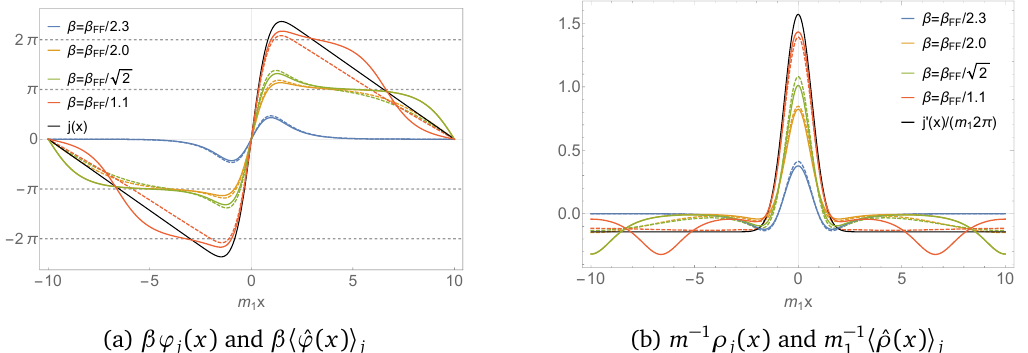
Figure 4.1: Comparing quantum and classical profiles for different values of the coupling β . (a) The QFT expectation values 〈 β ˆ ϕ ( x ) 〉 (dashed lines) and the classical lowest en- j ( x ) (continuous lines). ergy configurations βϕ j 〈 ˆ ρ ( x ) 〉 (b) The corresponding topological charge densities m − 1 in the quantum case j 1 ( x ) in the classical case (continuous lines). (dashed lines) and m − 1 ρ j = 18, m σ = 2 / 3; dif- L = 20, m = m A / m The parameters are (cid:96) = m , β (cid:112) 1 1 FF 1 1 = ferent β values are shown with different colours and β 4 π . The classical FF solutions for the two intermediate β values have βϕ ( 0 ) = π and are shifted by − π . The TCSA profiles 〈 ˆ ρ ( x ) 〉 = 24,26,28 and were extrapolated using cut-offs e j c 30, and the corresponding profiles β 〈 ˆ ϕ ( x ) 〉 were obtained by spatial integration of j = β 〈 ∂ ˆ ϕ ( x ) 〉 2 π 〈 ˆ ρ ( x ) 〉 , fixing the zero mode by requiring the result to vanish at j x j the origin x =